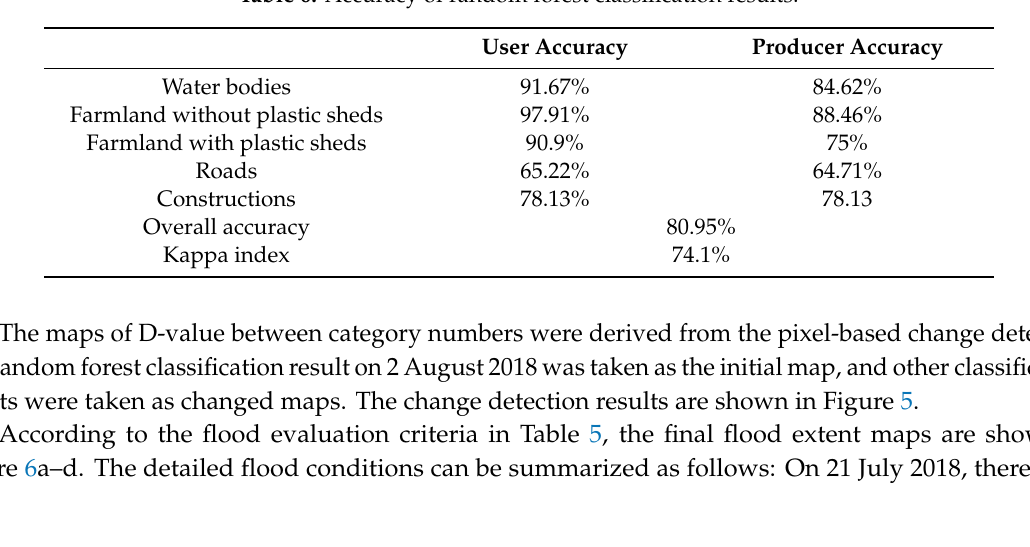
Table 6. Accuracy of random forest classification